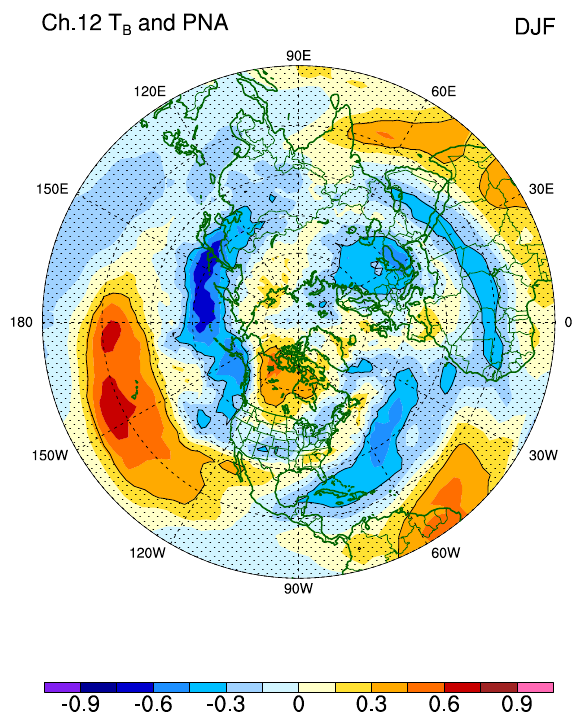
Fig. 9. Same as Fig. 7 for correlations between channel 12 T B and PNA